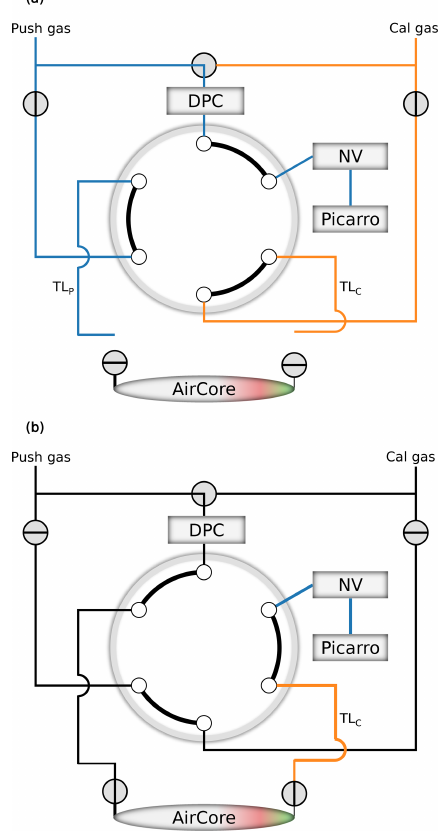
Figure 1. Analytical setup for AirCore measurements. Pressure is controlled by the digital pressure controller (DPC). Compared to the previously published setup by Engel et al. (2017), the mass flow controller has been replaced by a needle valve (NV). The Picarro operates in inlet control mode. In the bypass or flushing position (a) push gas (PG) is measured bypassing the AirCore while the transfer lines (TsL) are being flushed: TL P with PG and TL C with a calibra- tion standard (Cal gas). Tubing that contains PG is indicated in blue, and Cal gas in orange. In the AirCore measurement position (b) the PG is passed through the AirCore and pushes the air to the Picarro. Directly after switching to (b) , a small amount of Cal gas is mea- sured that has been enclosed by the transfer line TL C . For clearness, in (b) only tubing containing gas that is measured at the beginning of the AirCore analysis is colored (adapted from Engel et al.,